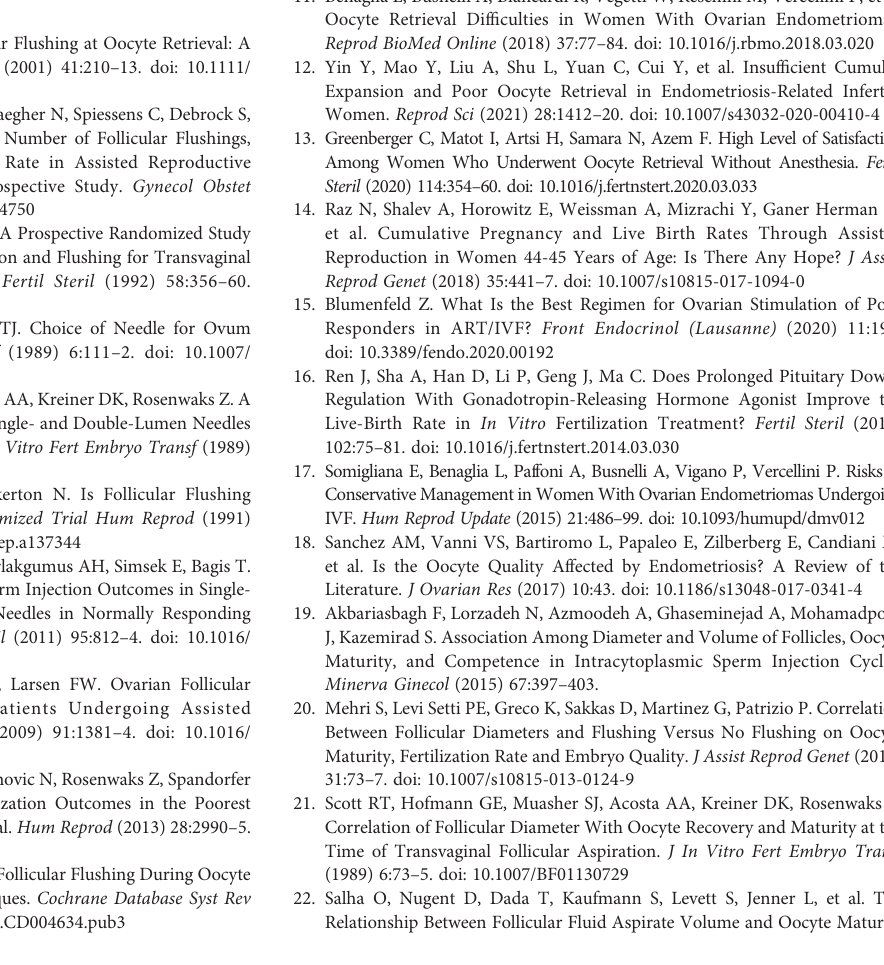
and normal responder